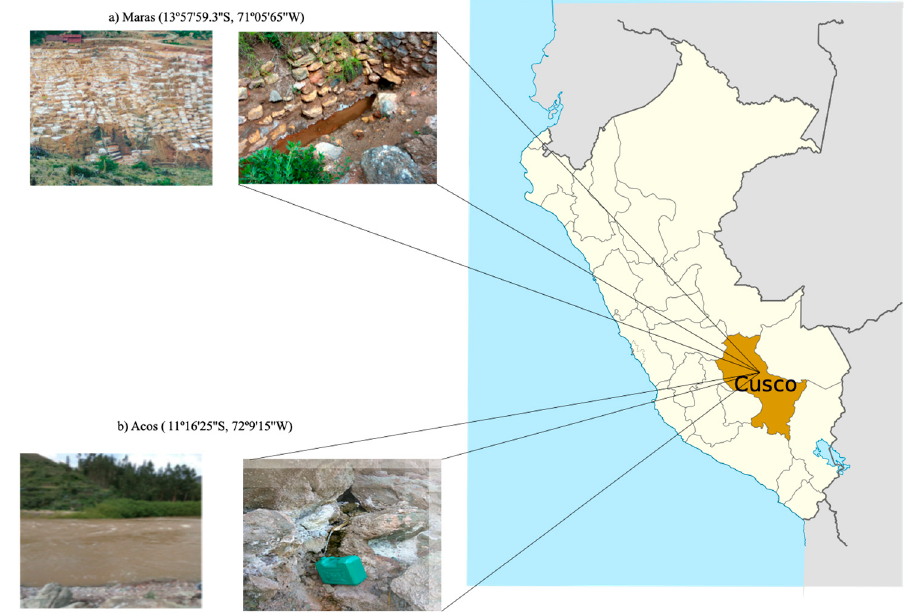
Figure 1. Location of the field sites in Cusco Peru. ( a ) Maras with 3000 shallow ponds. ( b ) Acos at the origin of the water. Table 1. Sequence features of hypersaline metagenomes from Cusco,